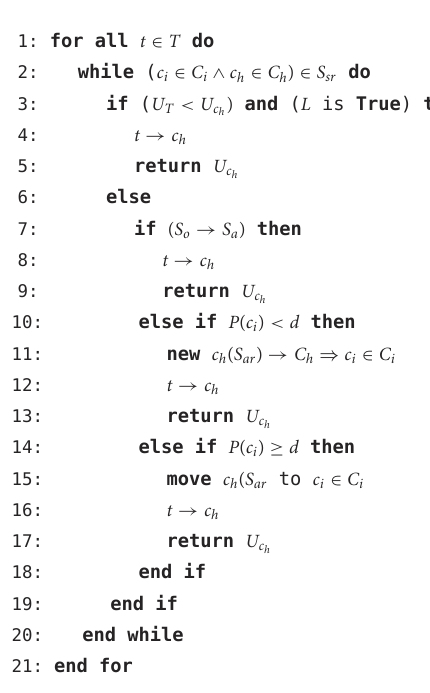
Algorithm 1. Green honeynet task